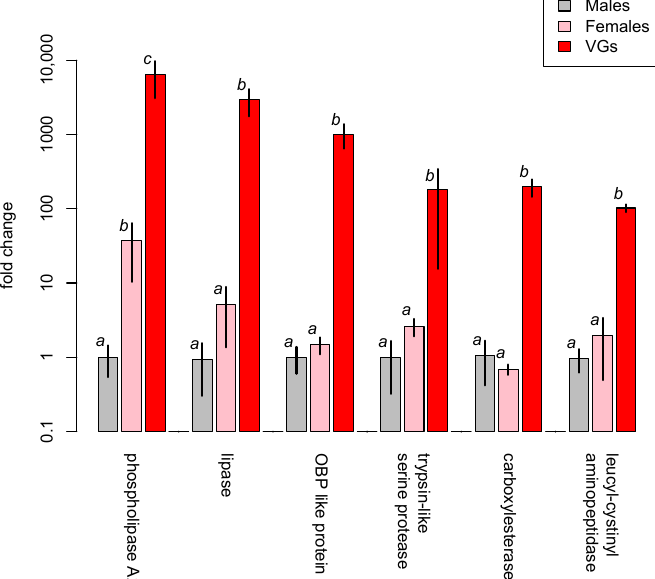
Figure 12. Expression of selected genes in terms of abundance of transcripts measured by qRT-PCR in H. nigricans females with their venom glands removed, whole males, and isolated venom glands. Results are presented as mean fold changes on a logarithmic scale, based of three independent biological replicates. Values are standardised with respect to females that had had their venom glands removed and which were assigned a value of 1. Error bars indicate standard error and letters indicate significant difference adjusted for multiple tests using Tukey’s HSD (Source: data from Figure 4 in